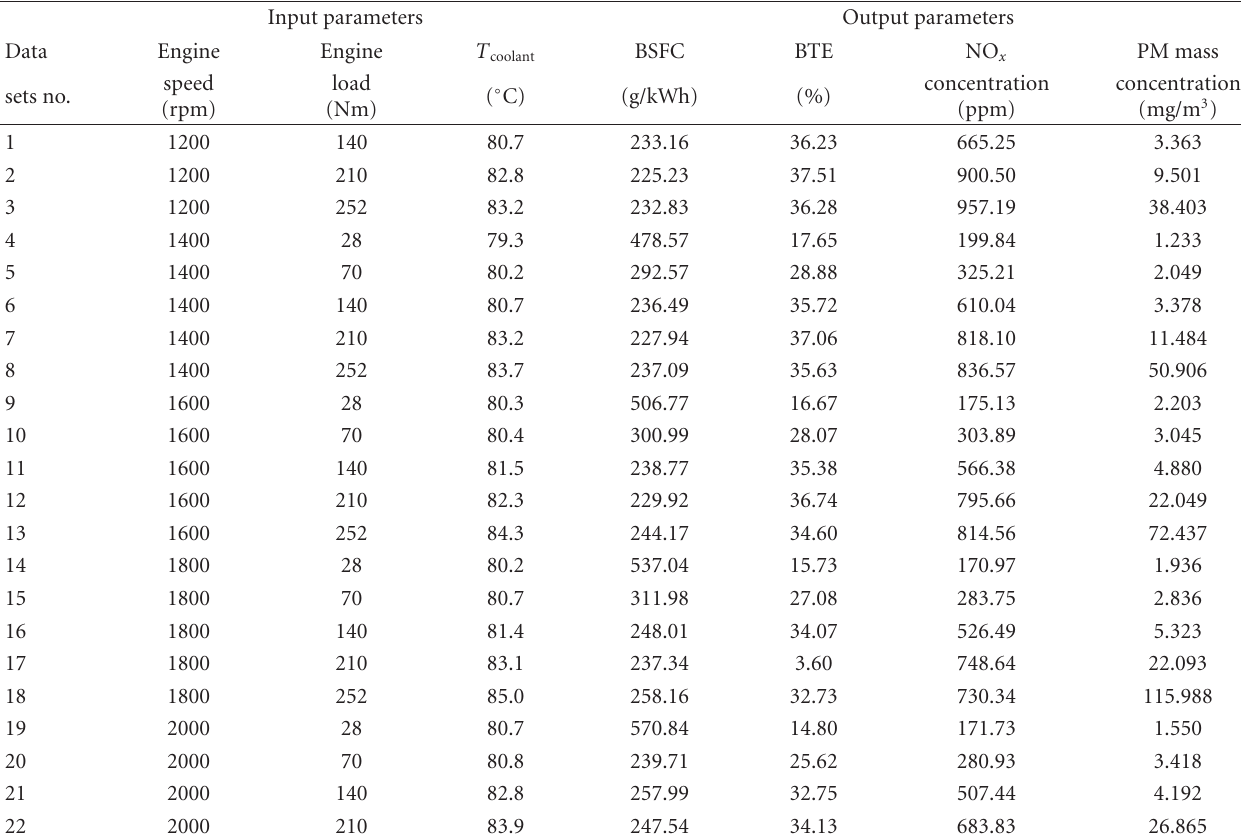
Table 2: Experimental dataset for model training and validation.